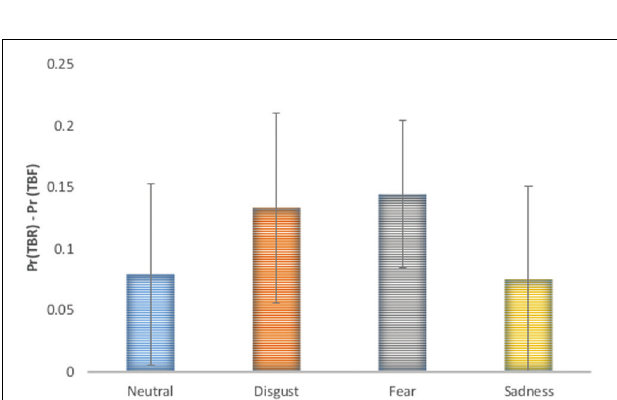
FIGURE 3 | Directed forgetting effect on false alarm recognition accuracy [Pr (TBR) – Pr(TBF)] was significant for each emotional category and no interaction between basic emotion and stimulus type was